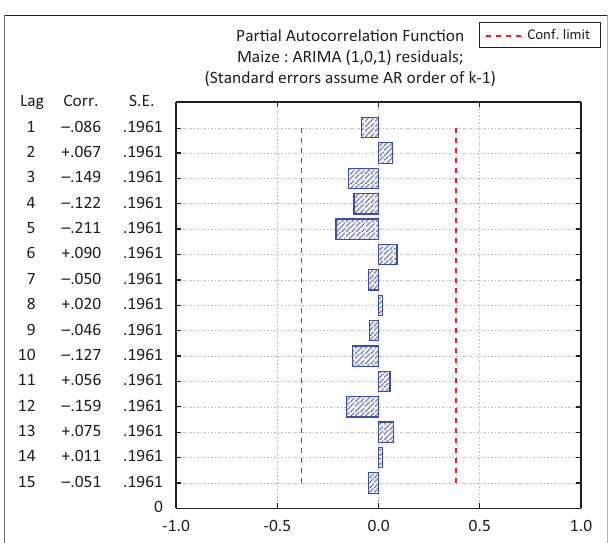
FIGURE 7: Partial autocorrelation function for grains for the chosen model.